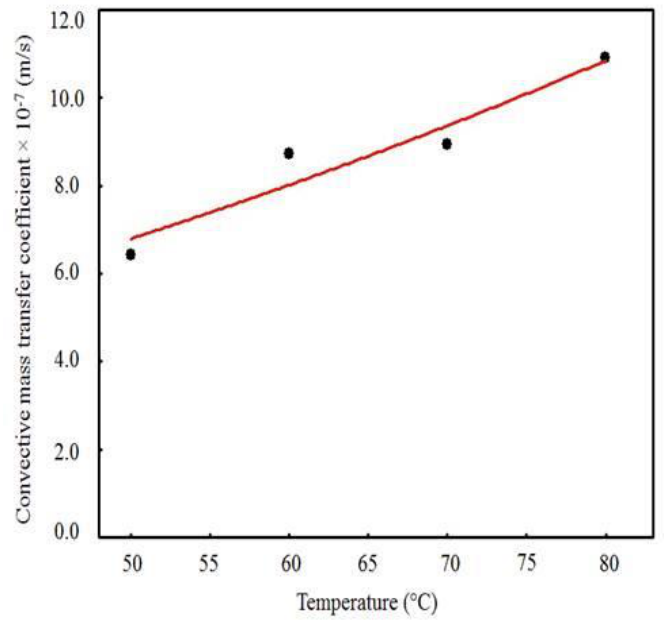
Figure 7. Convective mass transfer coefficient versus drying air temperature.